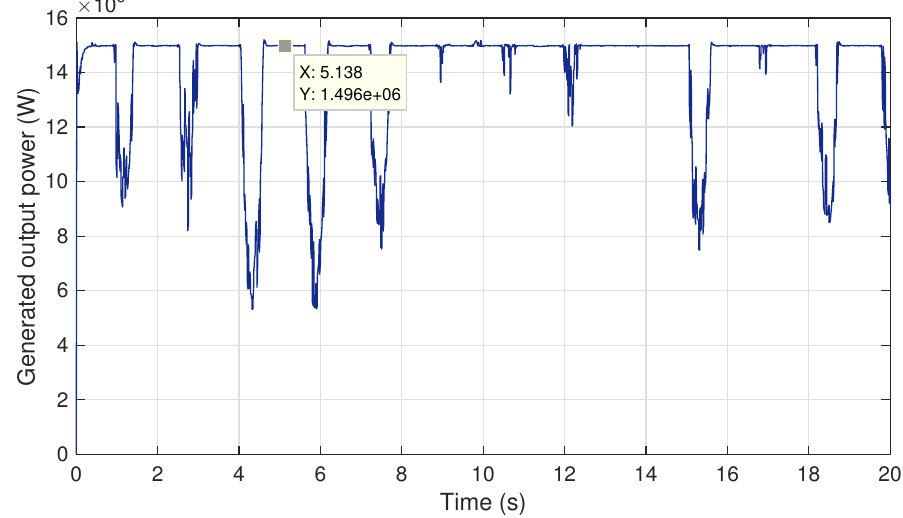
Figure 23. Case 2: Output power